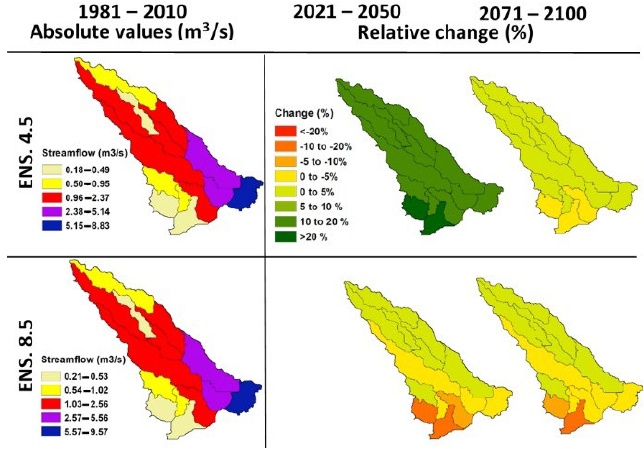
Figure 8. Catchment-scale distribution of annual average streamflow for the reference period (mm) and the relative change compared to the reference period (%) for each RCP.